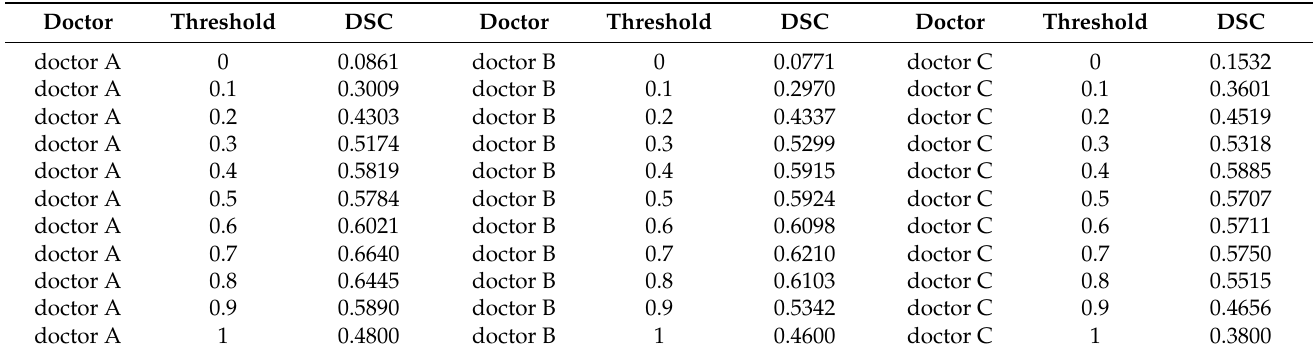
Table 1. The results of Different threshold Faster R-CNN R50-FPN Model and Doctor.